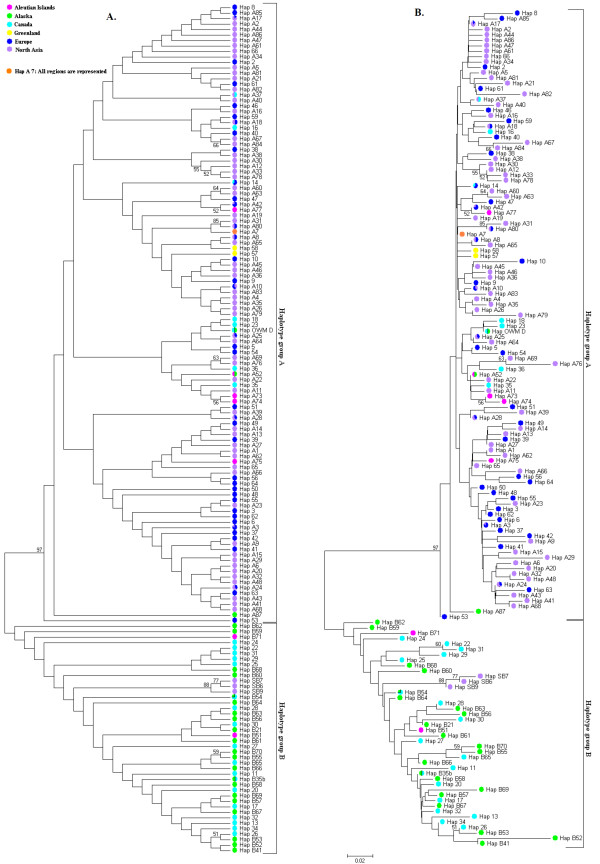
Unrooted Neighbour Joining tree illustrating clade A and B mtDNA control region haplotypes. Bootstrap values (500 replicates) are shown next to the branches if > 50%. Positions containing gaps are removed by pairwise deletion. Haplotype names and colours of the dots correspond to the ones in Figure 1. A: Tree ignoring branch lengths. B: Branch lengths scaled to evolutionary distances (sum of branch lengths = 2.65).